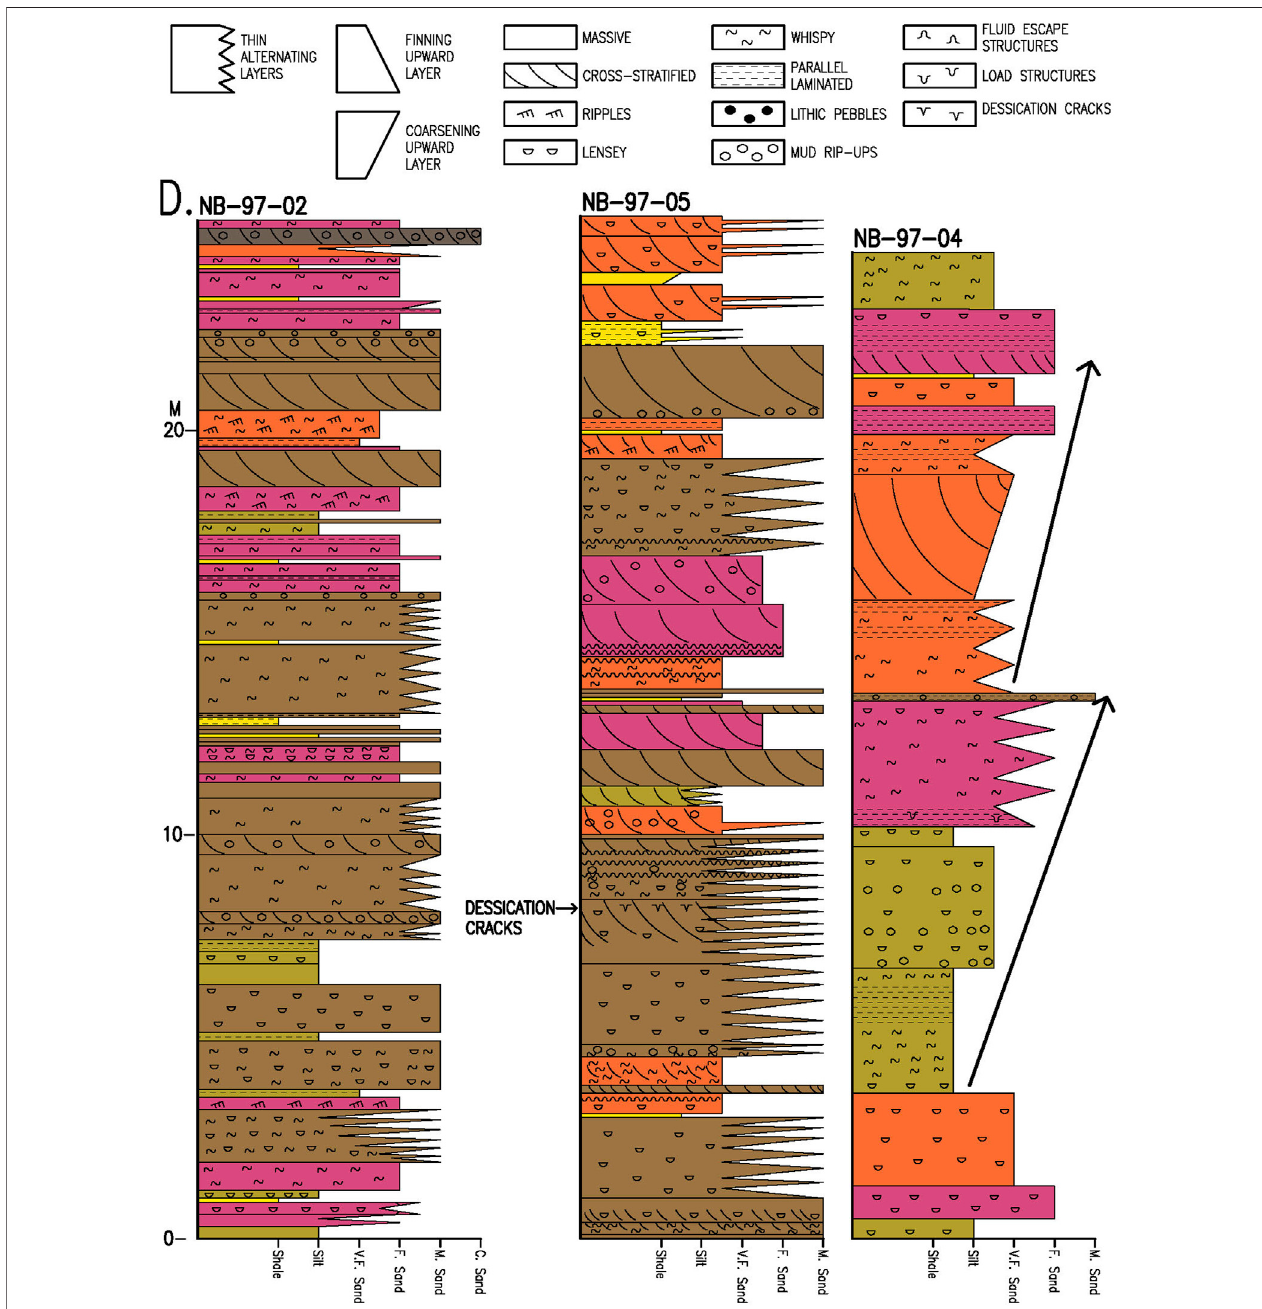
FIGURE 9 | Detail of strata in the upper heterogeneous assemblage. Similar to the strata forming the top of the middle coarsening-upwards assemblage grainsize fi nes from NB-97-05 in the northeast to NB-97-04 in the southwest ( Figure 8 ). In addition the fi ner grained sediment in NB-97-04 are is organized into approximately 10 m thick coarsening upwards cycles. Location of detailed sections in D depicted on Figure 2